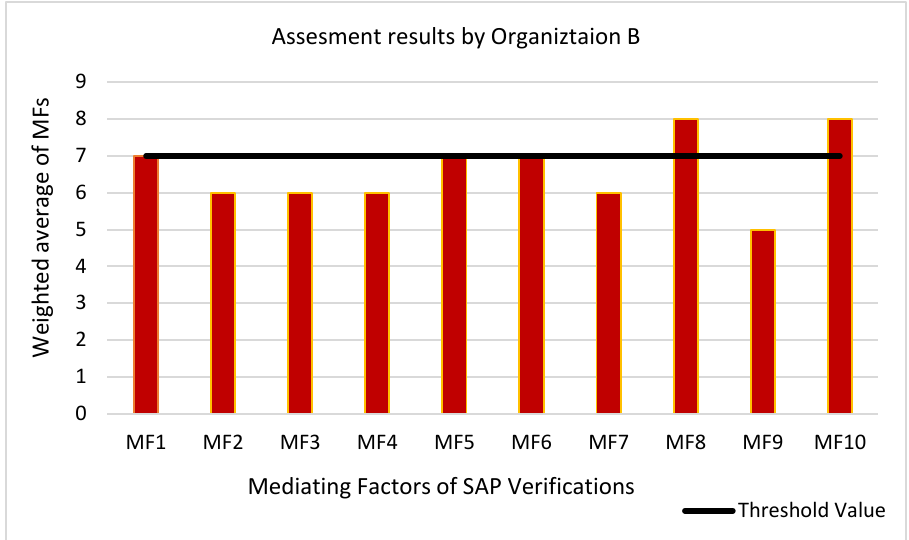
Figure 5. Assessment results by Organization B for the identified MFs .